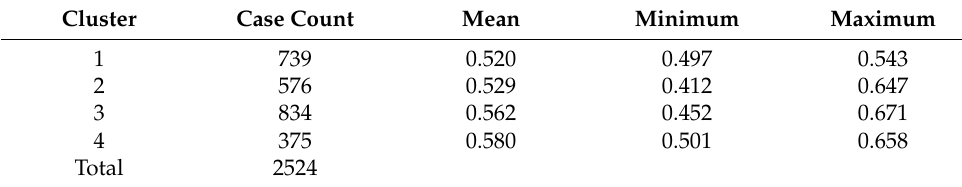
Table 3. Silhouette statistics of the four-cluster